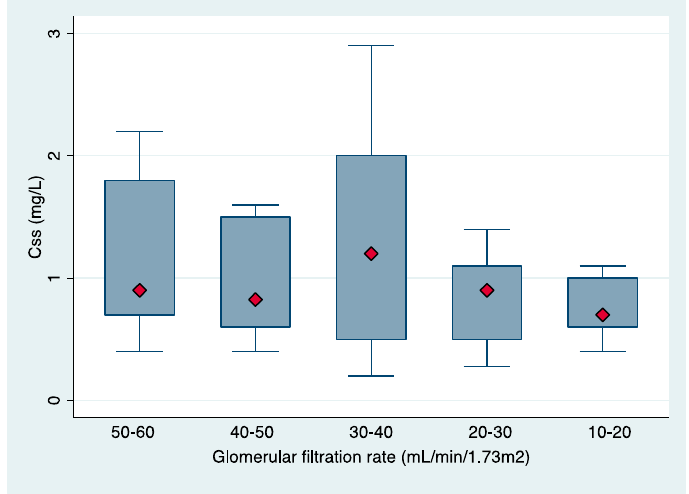
Figure 1. Boxplot of achieved C ss,avg in different intervals of baseline glomerular filtration rate.